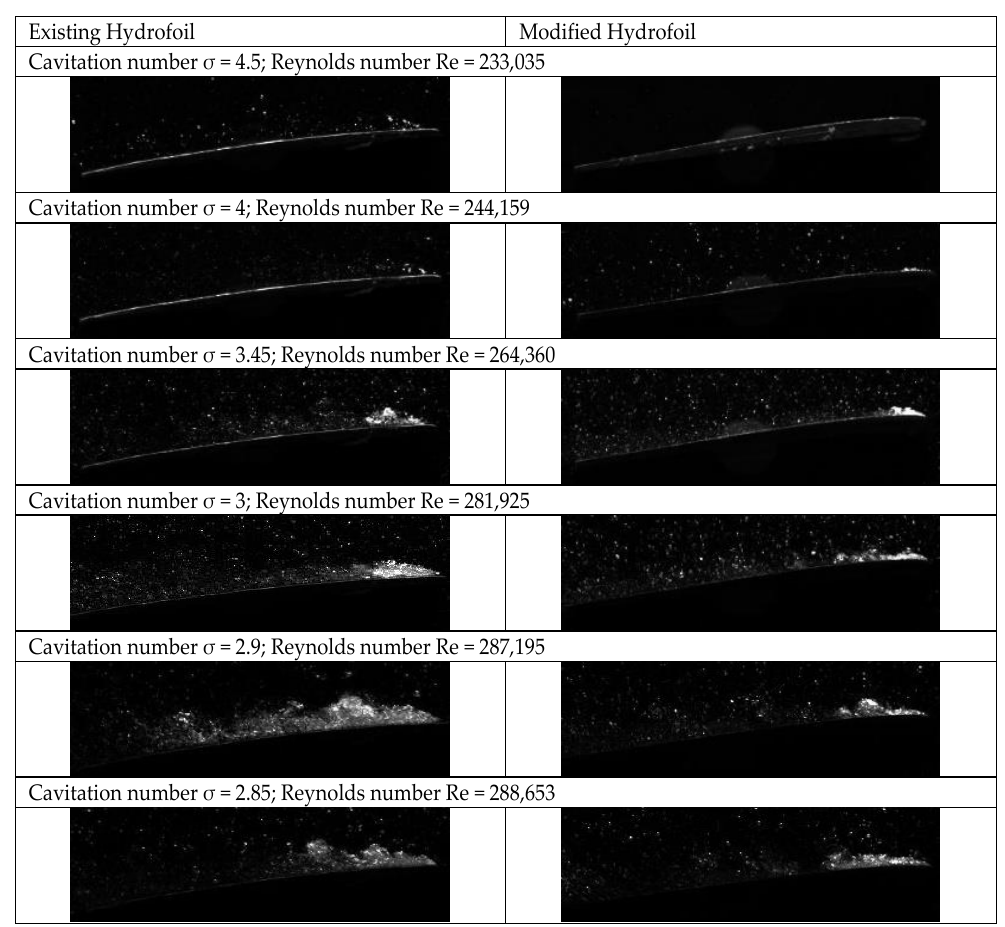
Figure 10. Visualization results of cavitation structures at p abs = 0.65 bar.